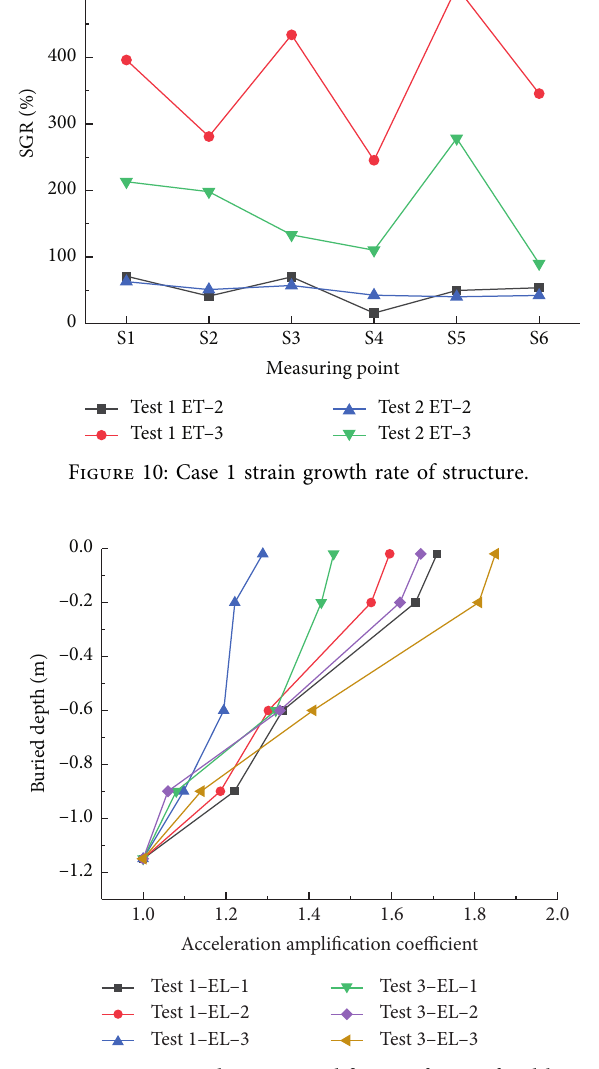
Figure 11: Case 2 acceleration amplification factor of soil